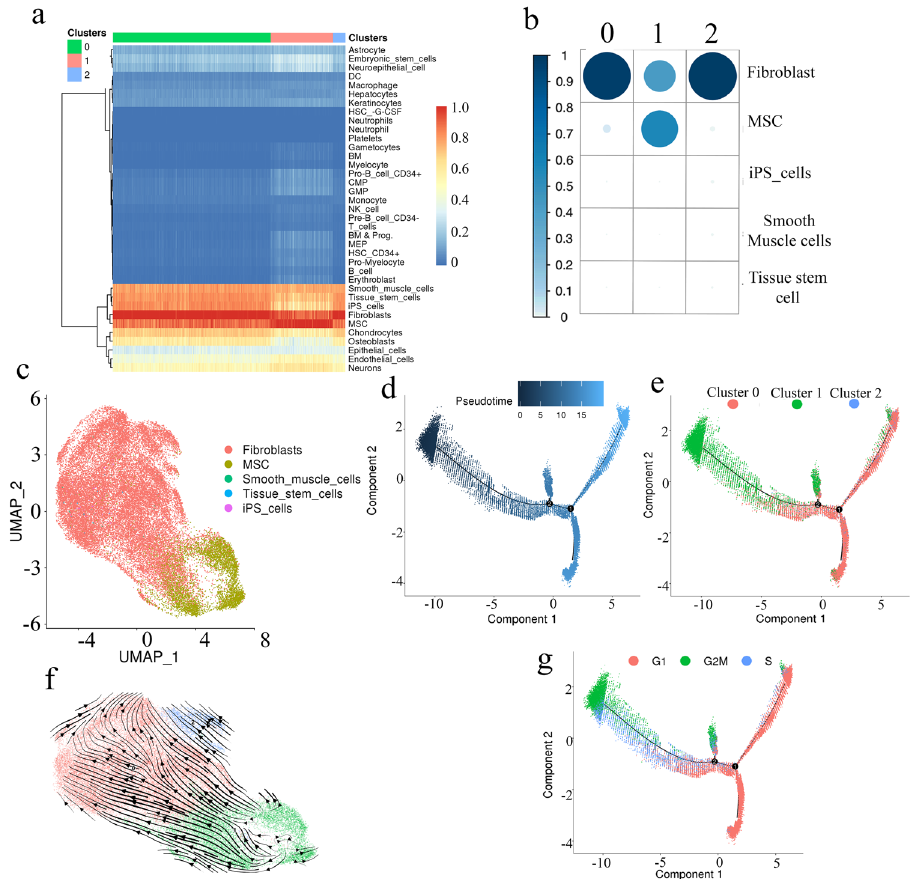
Fig. 3 Cell type identi fi cation. SingleR was used to assign cell types based on transcriptomic signatures. The strongest correlations were observed in red with the weakest in blue. a Heatmap visualisation of the transcriptomic signatures aligned strongly with cells of mesenchymal origin. This was consistent across all three clusters, although the actual identity varied across the clusters. b Distribution of the top cell type assignments across the three clusters. Circle size represents the proportion of each cell type identi fi ed in each cluster. Analysis indicated that fi broblasts were the predominant cells in cluster 0 and cluster 2. The majority of cluster 1 were MSCs, although 42.53% were considered fi broblast. c UMAP plot of scRNA-seq data labelled by cell type. Overlay of cell type on spatially resolved distribution depicts fi broblasts as the predominant cell in cluster 0 and cluster 2 and an association between MSCs with cluster 1. d Pseudotime cell fate trajectory analysis using Monocle 2 placed each cell on a continuum based on the similarity of the transcriptome. e An overlay of the clusters identi fi ed the majority of the cluster 1 MSCs as the root source directing cell fate lineage towards the fi broblast major cluster (cluster 0). The additional fi broblast minor cluster (cluster 2) was uniformly scattered across the continuum. f scVelo analysis supports the developmental trajectory direction of cluster 1 (green) to cluster 0 (red). A similar direction is also taken by cluster 2. g An overlay of the cell cycle analysis identi fi es the majority of G2M phase cells aligned with earlier trajectory and MSCs, transitioning to S phase followed by movement towards the majority G1 stage